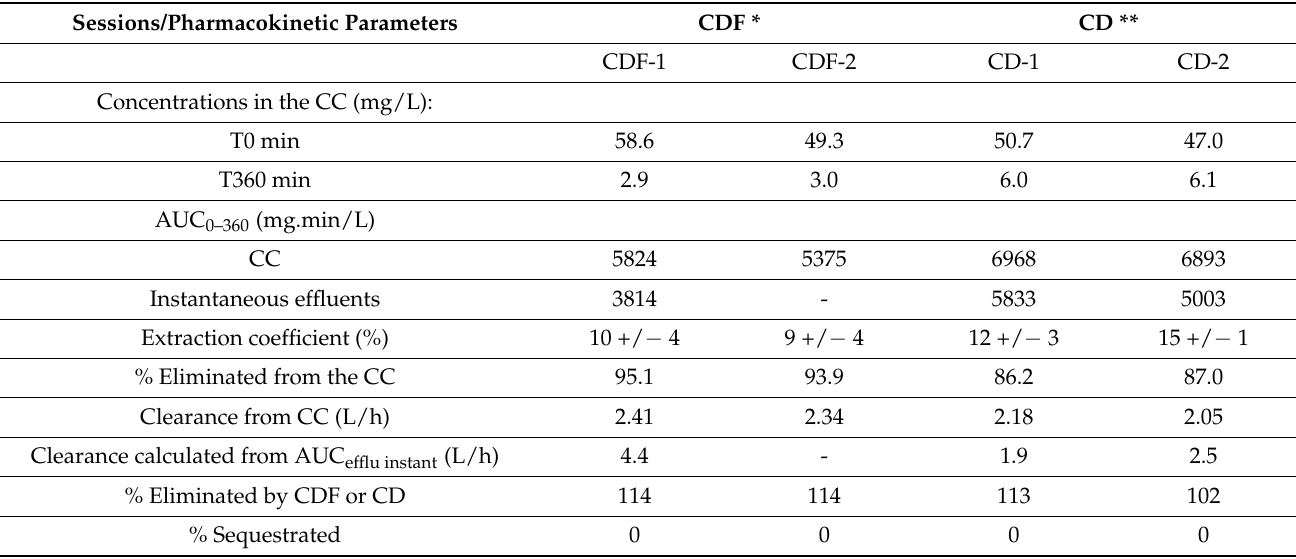
Table 1. Pharmacokinetic parameters of vancomycin elimination from the CC in each session in the CDF and CD modes by the ST ®